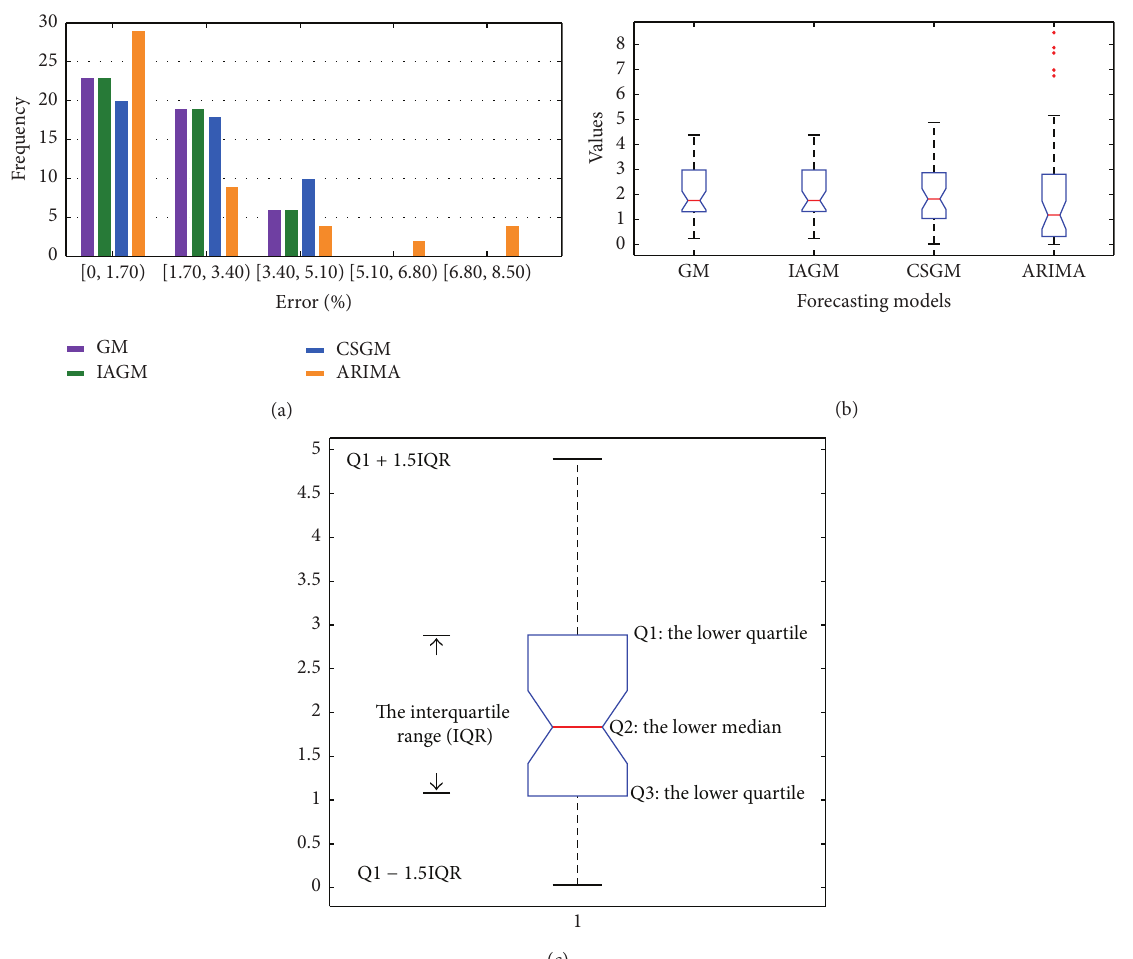
Figure 7: The frequency diagram and box plot for the GM, IAGM, CSGM, and ARIMA models. (a) The frequency diagram of four forecasting models. The interval on the 𝑥 -axis is the range of error. (b) The box plot of four forecasting models. Box plots are a way of graphically depicting groups of numerical data through their quartiles. Whiskers from the box indicate variability outside the upper and lower quartiles. Outliers are plotted in red circles. (c) A detailed graphic presentation of a box plot. The central mark is the median, the edges of the box are the lower and upper quartiles, the whiskers extend to the most extreme data points not considering outliers, and outliers are plotted